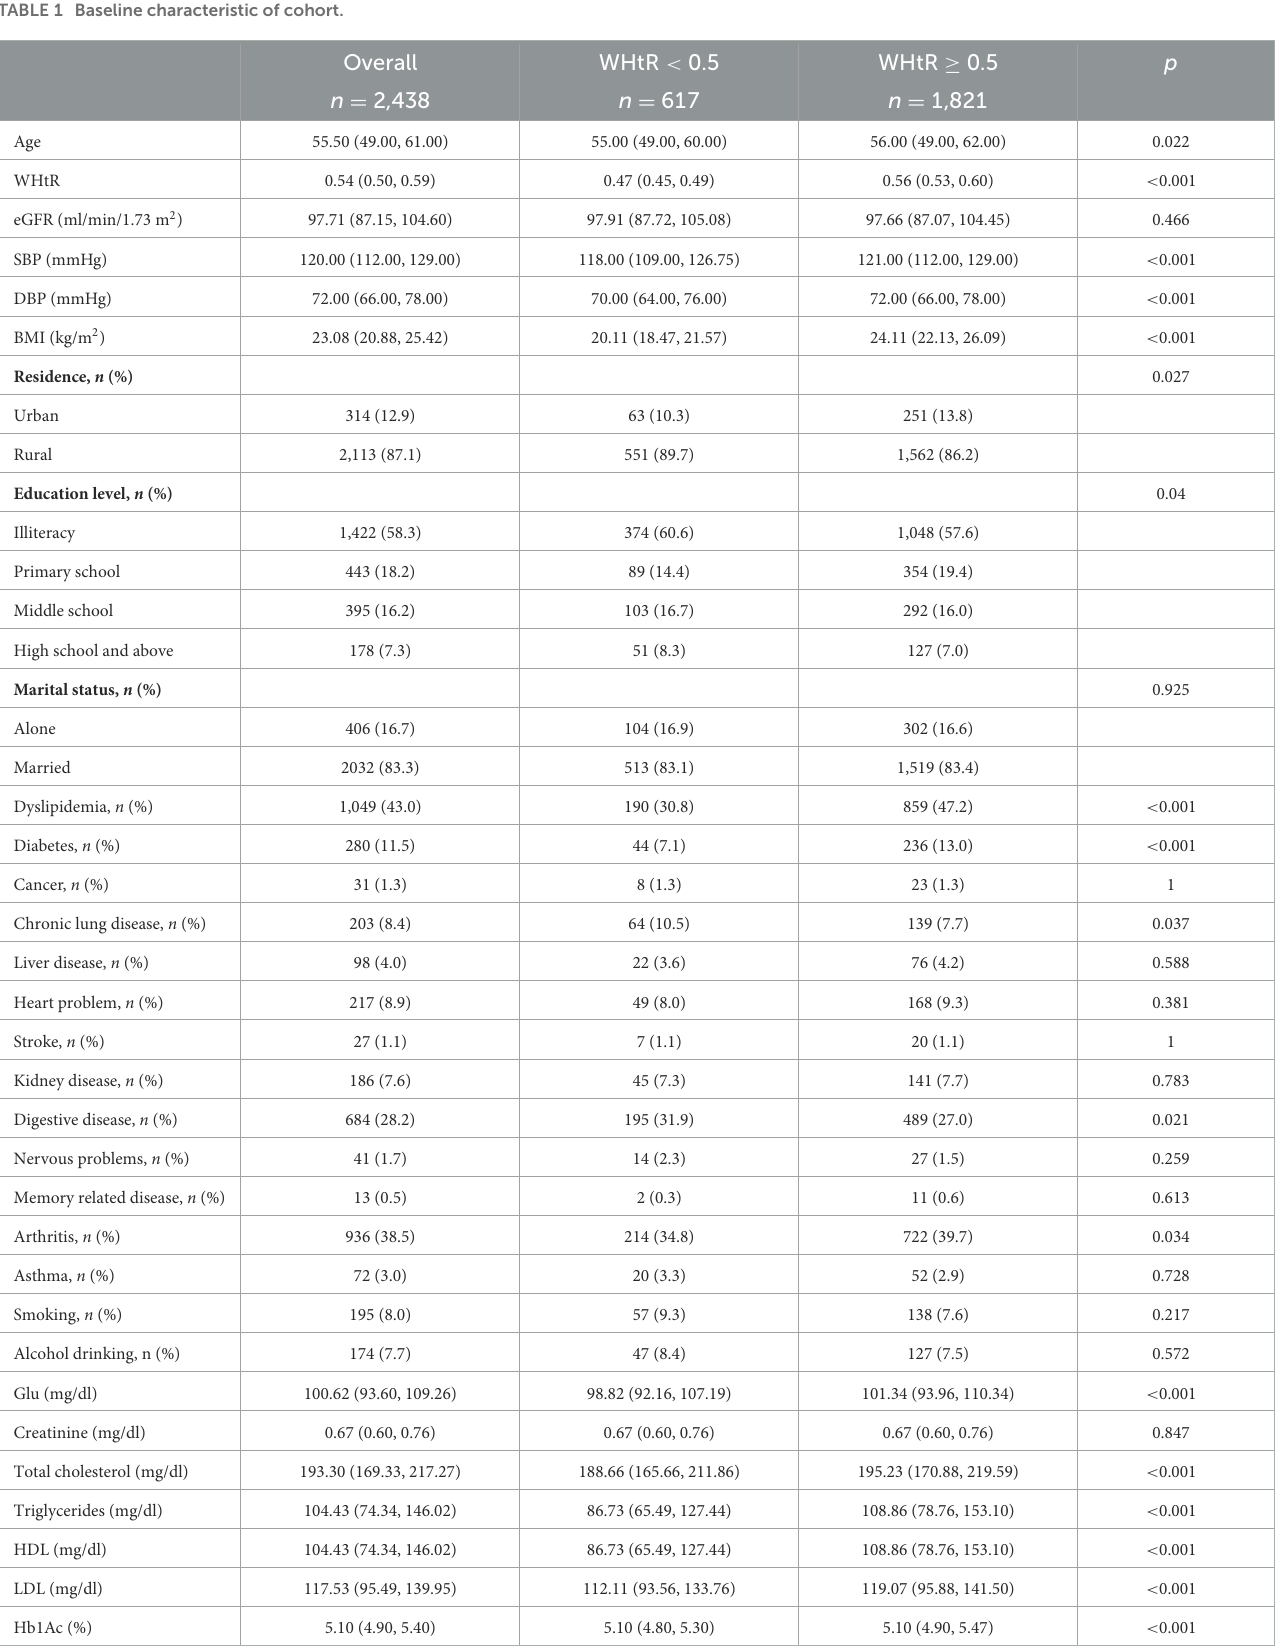
TABLE 1 Baseline characteristic of